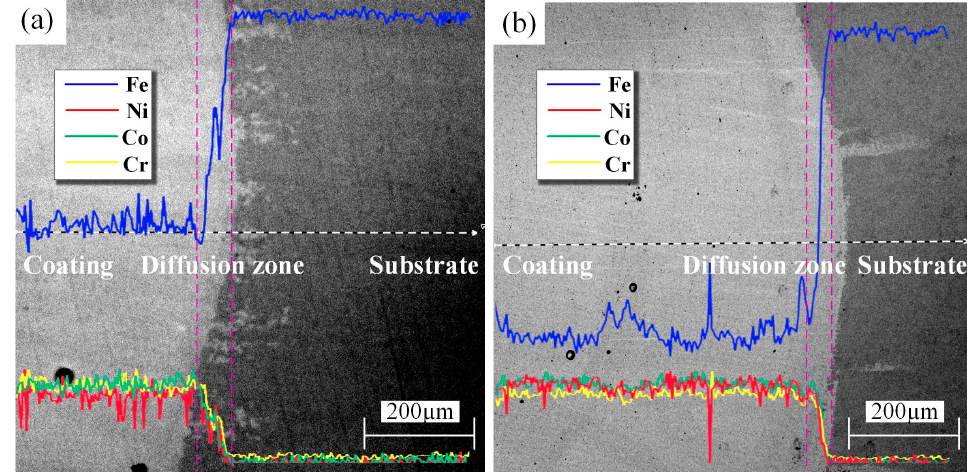
Figure 6. Elements distribution of samples. ( a ) FeCoNiCr, ( b ) CoCrNi. During the laser cladding process, the difference in the coefficients of thermal expan- sion between the substrate and laser cladding coating led to thermal stress generation. This caused a greater stress gradient from the substrate material to the cladding layer surface and an uneven distribution of internal stress in the cladding coating. Moreover, the internal pores and defects resulted in the uneven hardness of the cladding coating surface. Figure 7a–c presents the metallographic structure images of the LC(FeCoNiCr) sample from the top of the coating to the substrate material, respectively. At the juncture of the coating with the substrate, the temperature gradient was the largest, and the grain growth rate was slow, leading to the formation of a plane crystal, as shown in Figure 7c. The cellular dendritic crystal zone was above the plane crystal, and there was a layer of coarse grains of cellular dendritic crystal, with an upward growth perpendicular to the substrate. When the plane crystal formed, the increase in substrate material temperature led to the decrease in the degree of subcooling, and thus the nucleation rate decreased but had little influence on the growth rate of the grains. The preferential growth direction of the grains is consistent with the opposite direction of the fastest heat dissipation direction; that is, upward diffusion from the substrate, which makes the grains grow upwards, perpendicular to the substrate, as shown in Figure 7b. The top grain was cooled in air with a greater degree of undercooling. The growth of columnar crystals was hindered at the solidification front. Moreover, as the degree of supercooling increased to a certain degree, many more new crystal nuclei appeared. They began to grow in all directions, formed an equiaxed-grain structure, and then prevented the growth of a columnar crystal. In addition, the heat flux at the top was greatly affected by the movement of the laser beam, leading to the growth direction of the equiaxed-grain structure parallel to the processing direction, as shown in Figure